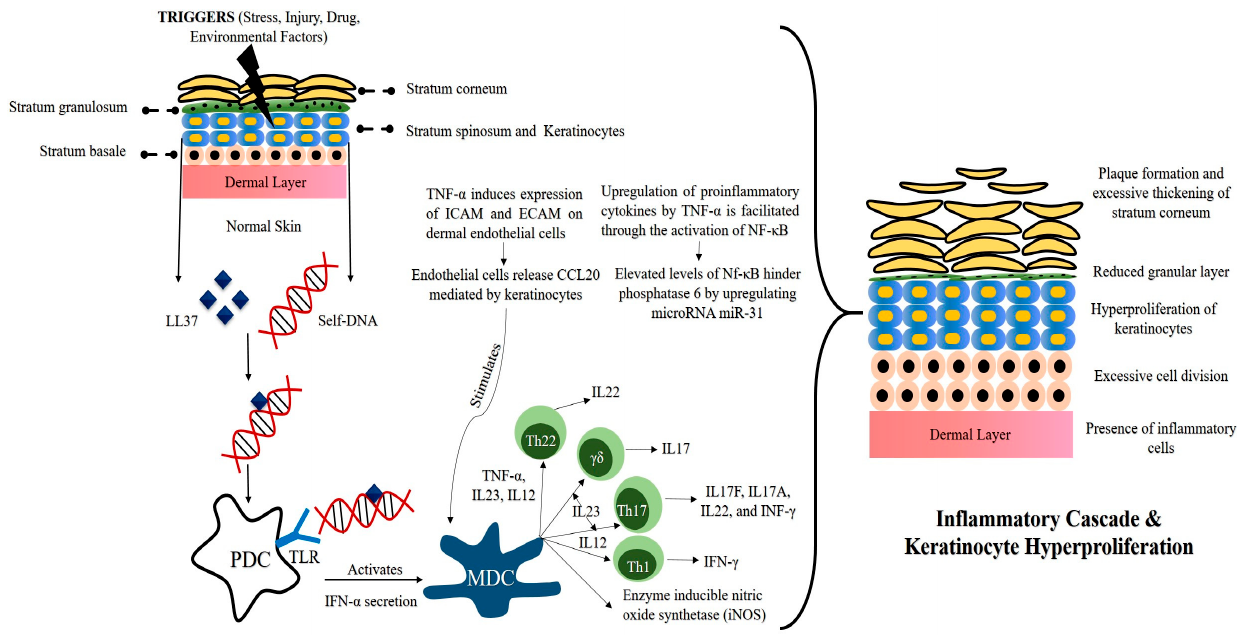
Figure 2. Pathophysiology of psoriasis disease.